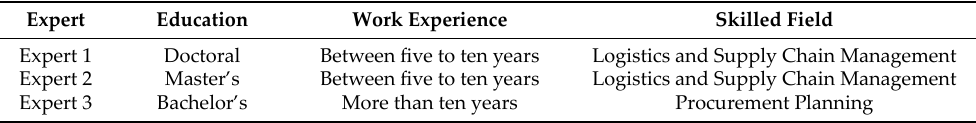
Table 4. Details of the three experts.